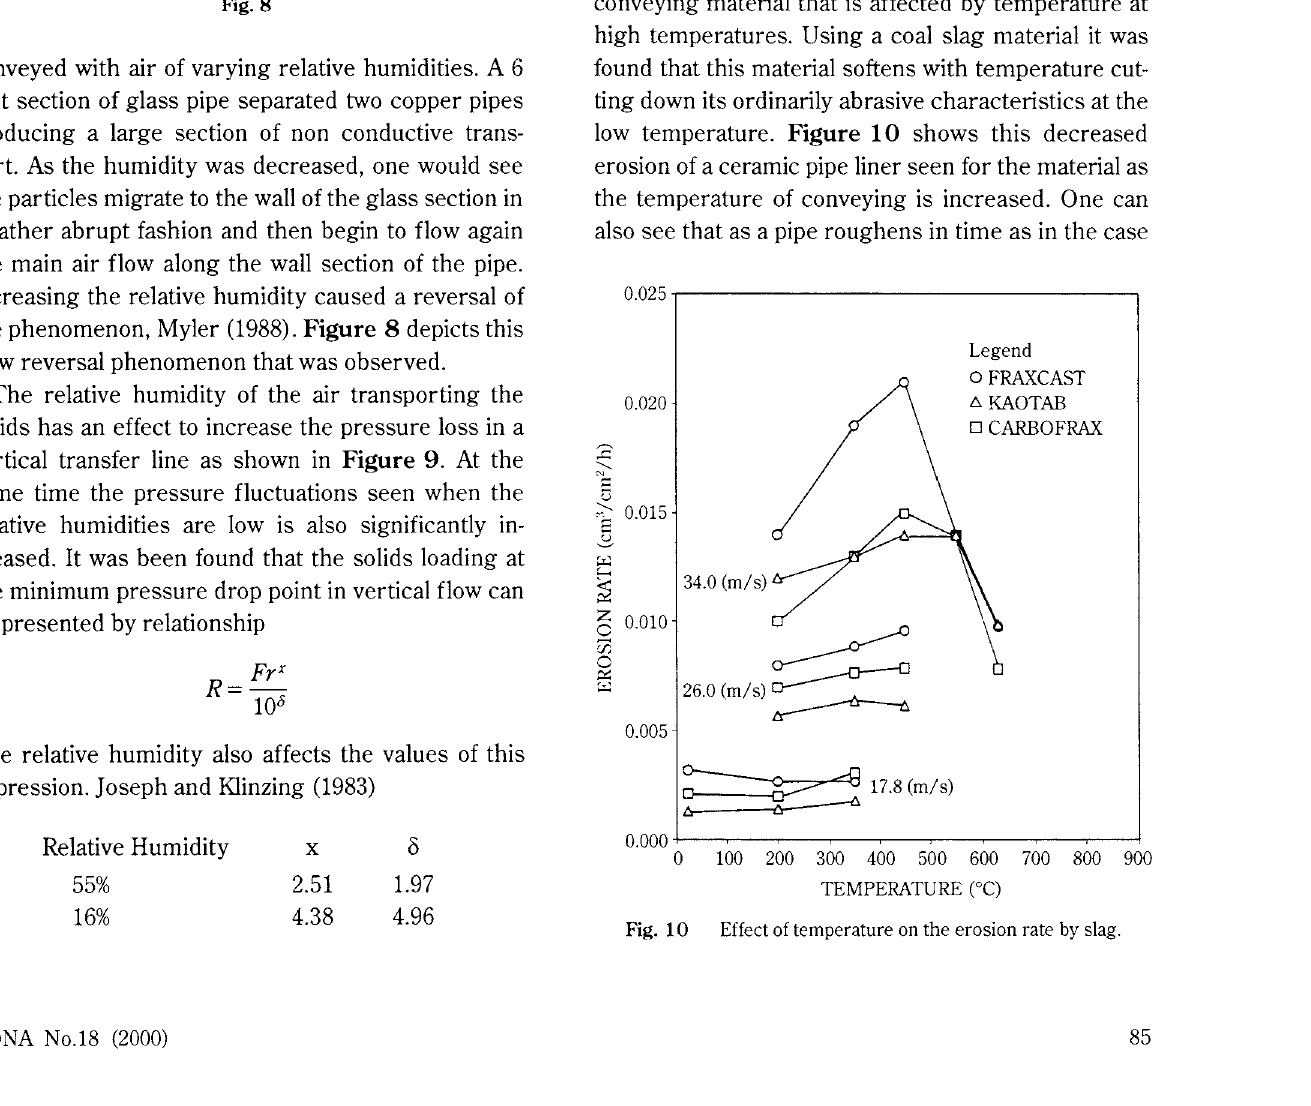
Effect of Relative Humidity on Pressure Drop Joseph and Klinzing also found under the presence